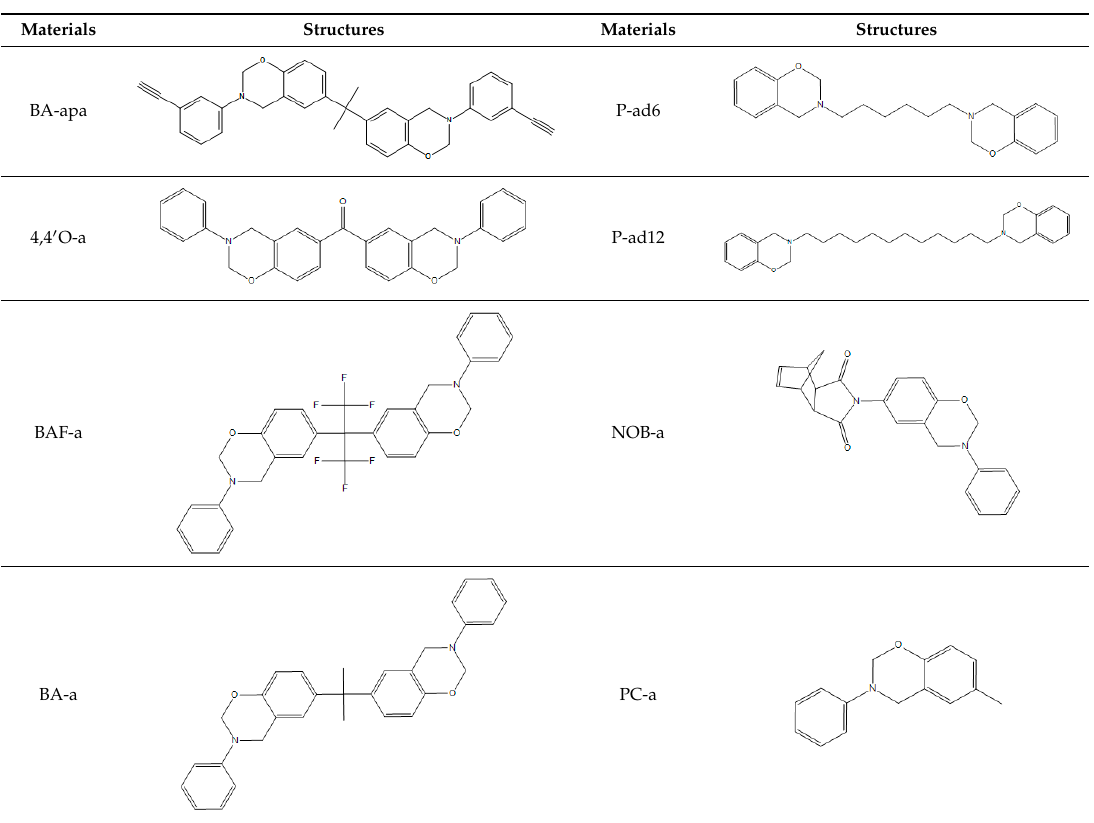
Figure 4. Actual char yield with 10% error bars and prediction char yield plotted together. (Blue squares: Actual char yield; Red triangles: Predicted char yield (within 10% percentage error); Green diamonds: Predicted char yield (exceeds 10% percentage error). Table 8. List of benzoxazines with percentage error more than 10%.